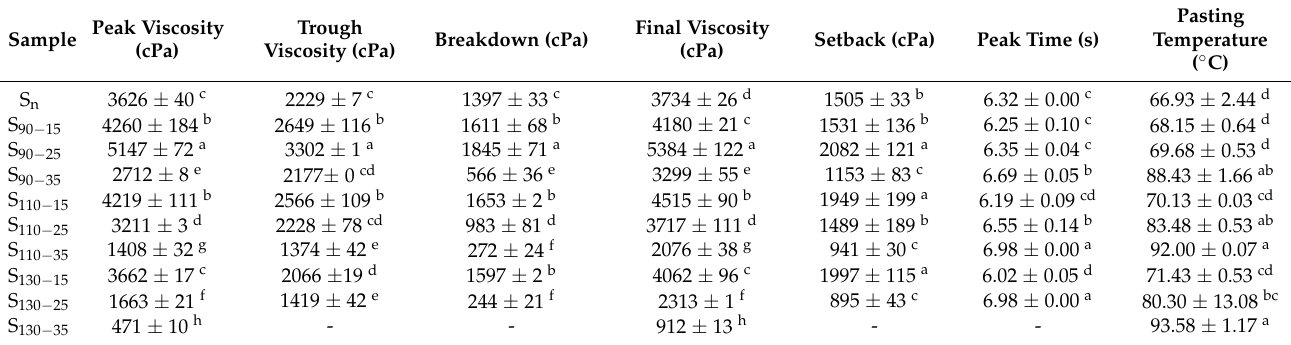
Table 1. Pasting properties of native and HMT HB